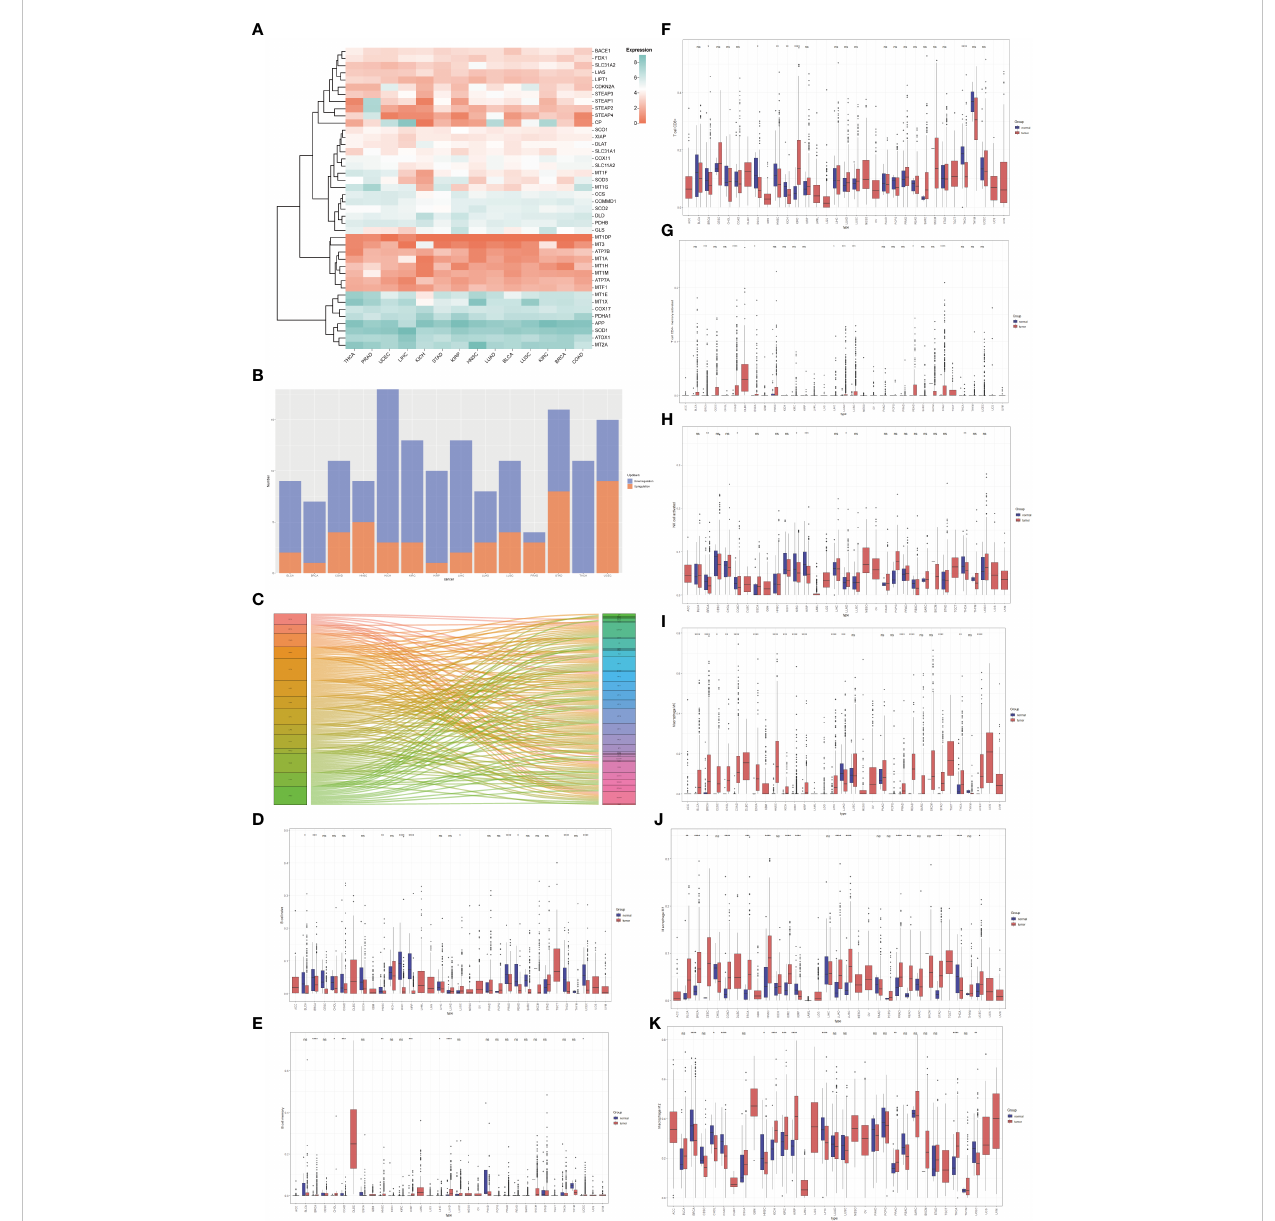
FIGURE 1 The pan-cancer analysis of copper-related genes. (A) Heatmap of copper-related genes showed different expression patterns across different types of cancers. (B) A stacked bar chart of copper-related genes in different types of cancer samples showed the number of differentially expressed genes. The red and blue colors represented upregulated and downregulated genes, respectively. (C) The Sankey diagram of differentially expressed copper-related genes across different cancer types. (D – K) Box plot comparison of the abundance of naive B cells (D) , memory B cells (E) , CD8 + T Cells (F) , memory CD4 + T cells (G) , activated NK cells (H) , M0 macrophages (I) , M1 macrophages (J) , and M2 macrophages (K) in different types of cancers compared with paired non-tumor samples. (* p < 0.05; ** p < 0.01; *** p < 0.001, **** p < 0.0001,NS: no signi fi